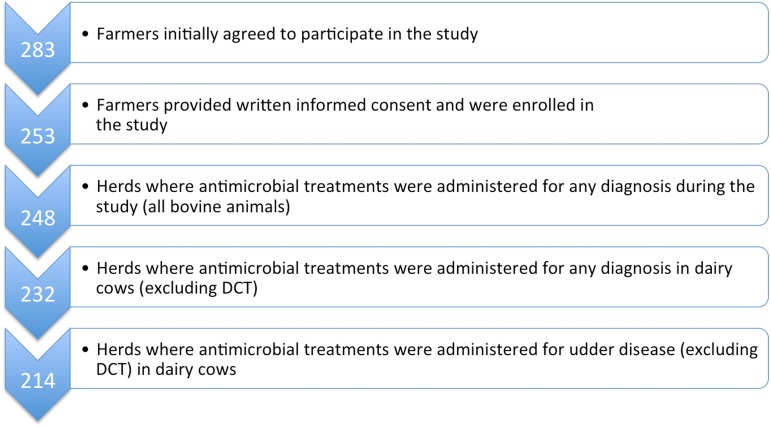
Flowchart to describe the study population with respect to participating herds and AMC data collection.AMC, antimicrobial consumption; DCT, dry cow therapy.